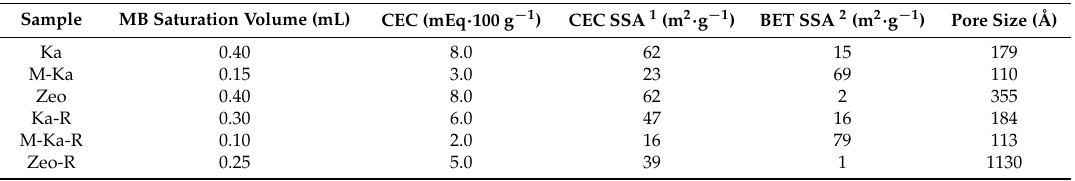
Table 4. CEC and BET specific surface areas for the precursors Ka, Ka-R, M-Ka, and M-Ka-R; and the final zeolites Zeo and Zeo-R.